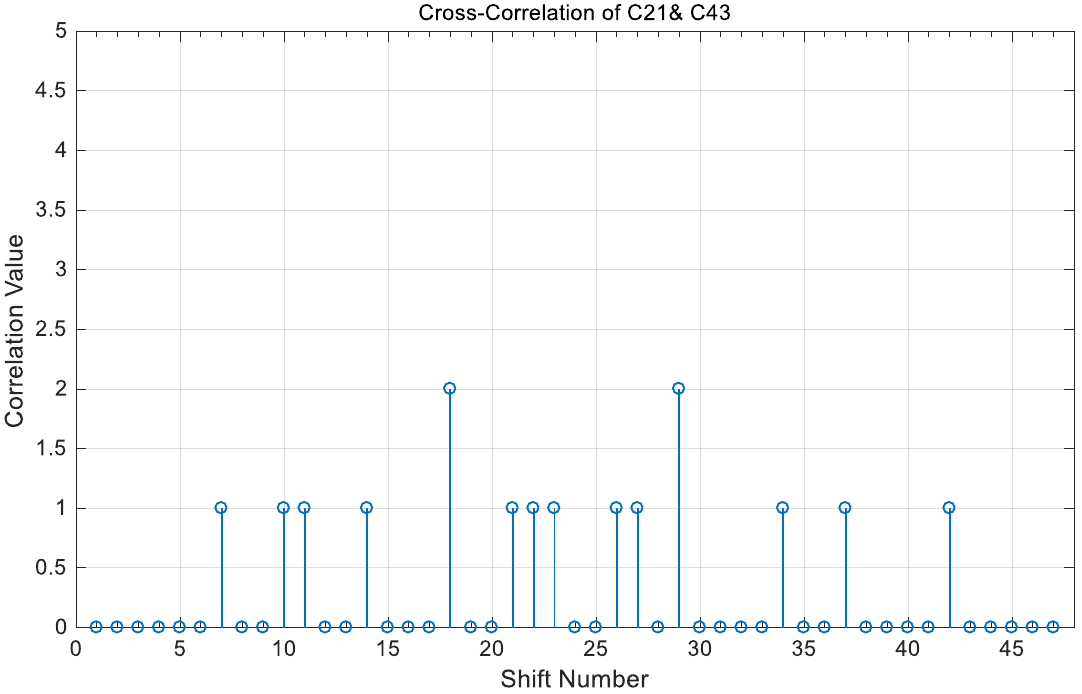
Figure 15. Cross-correlation between 𝐶 21 and 𝐶 43 sequences from different groups, 𝑃 1 = 5 and 𝑃 2 = 7.